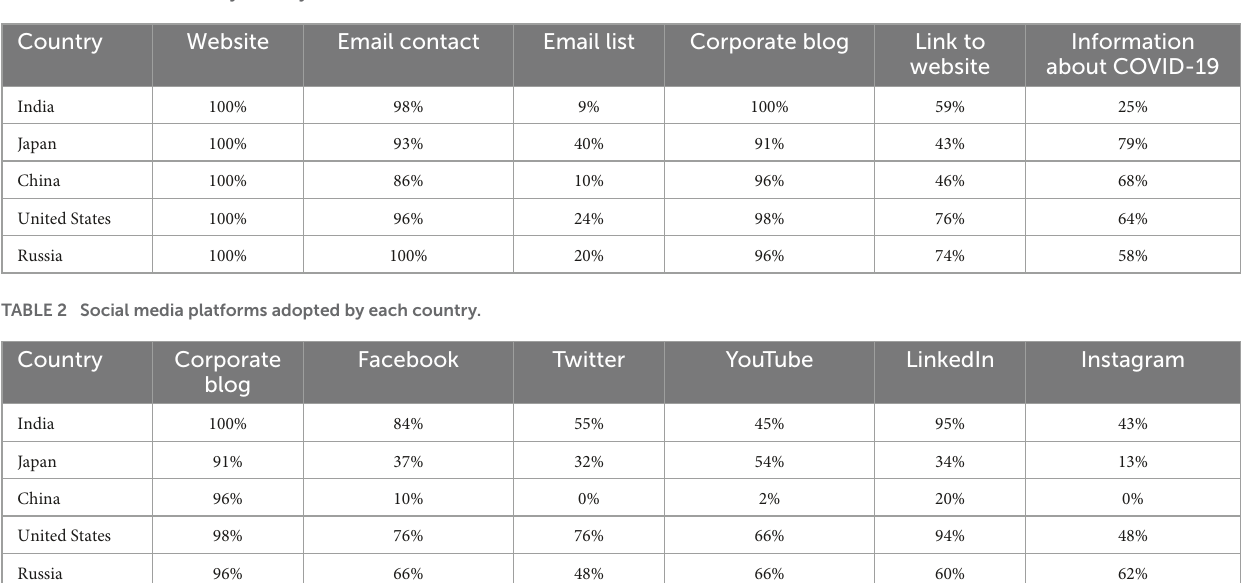
TABLE 1 Social media use by country.